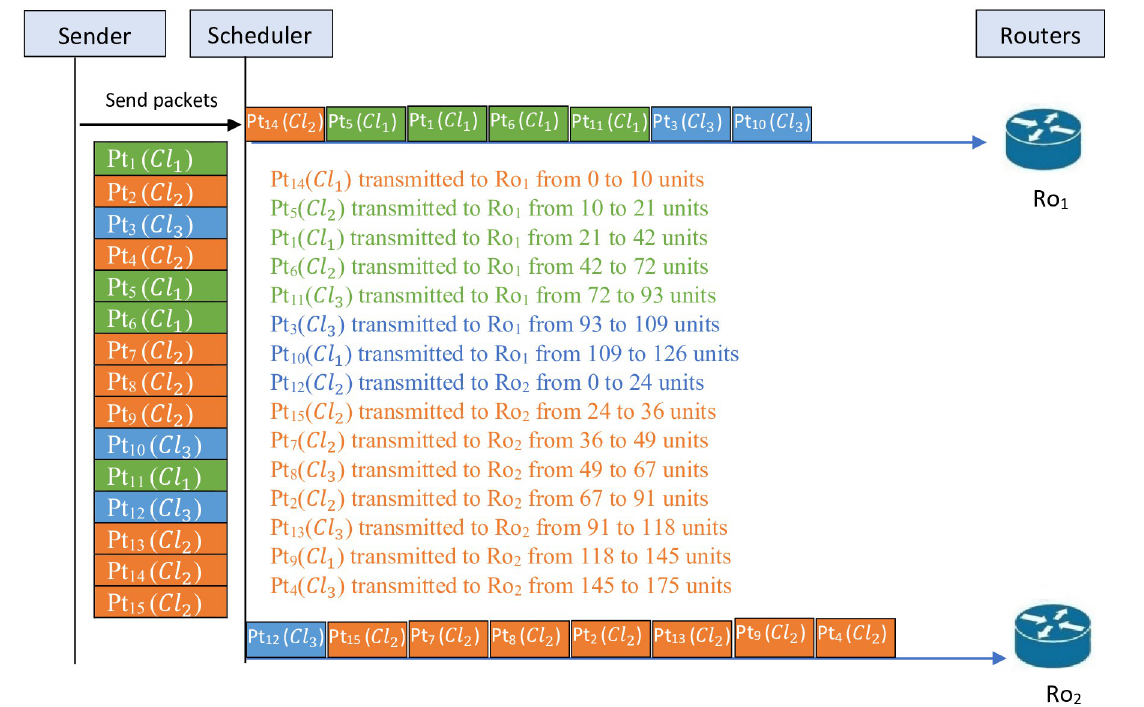
Fig 6. Schedule after applying the lifting procedure for Example